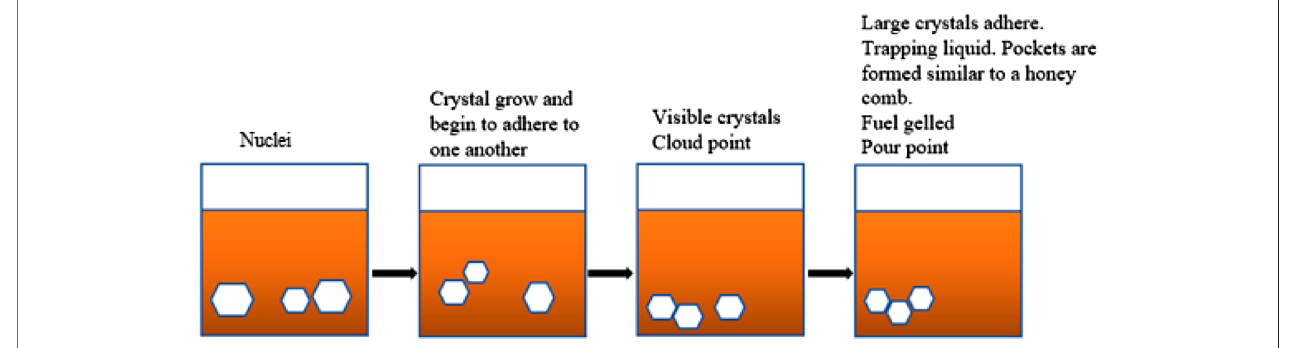
FIGURE 2 | Mechanisms of the cold fl ow of biodiesel (Verma et al., 2016).